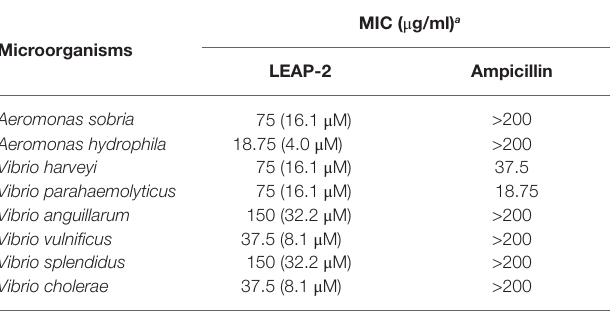
TABLE 2 | Antimicrobial activities of topmouth culter LEAP-2 in vitro .